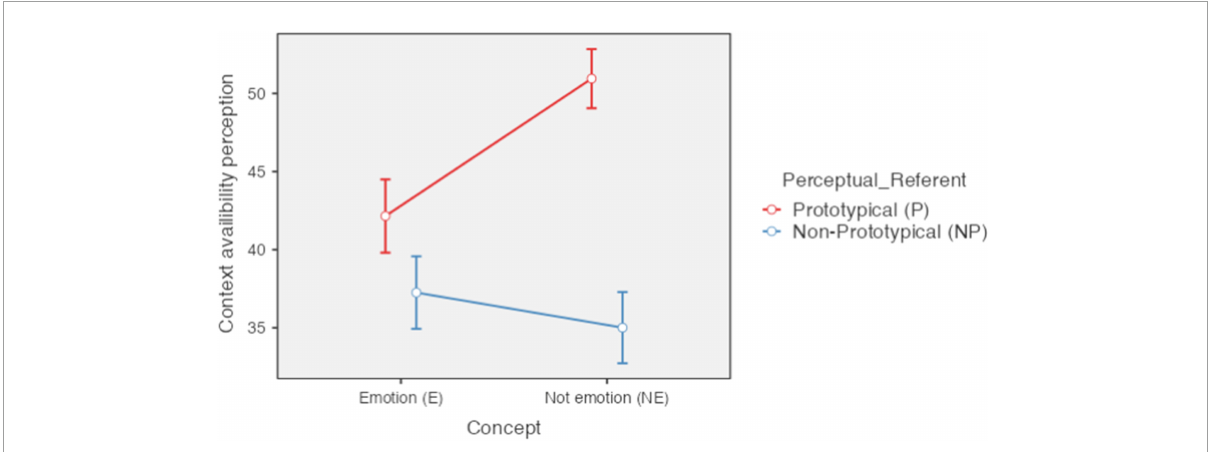
FIGURE3 Context availability perception according to type of concept and type of perceptual referent. Error bars 95% CI; significant differences between concepts of, basic and secondary emotions (E-P_E-NP); basic emotion and concrete (E-P_NE-P); basic emotion and abstract